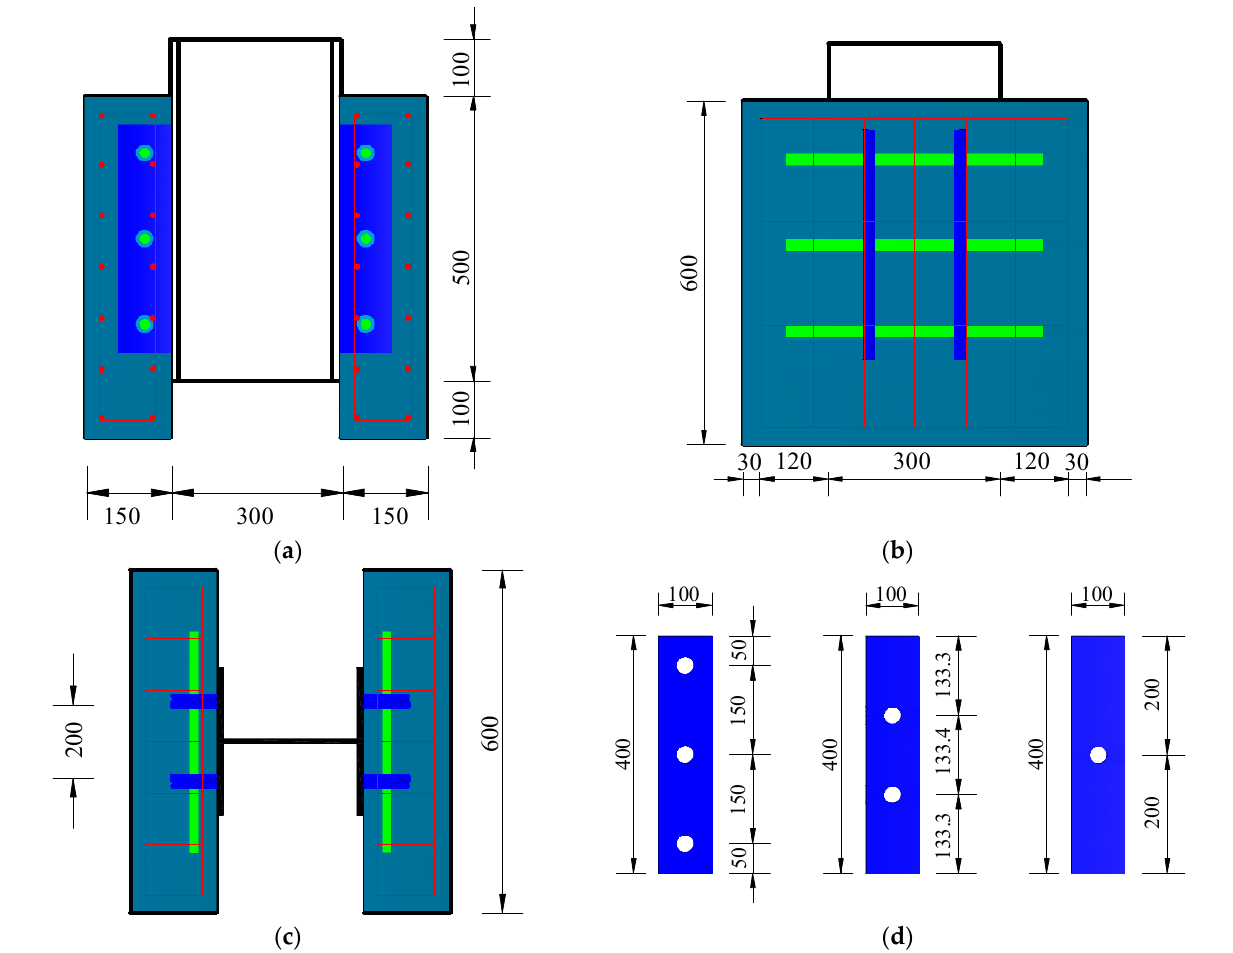
Figure 1. Specimen dimensions: ( a ) front view; ( b ) side view; ( c ) plan view; and ( d ) perforated steel plate (unit: mm).